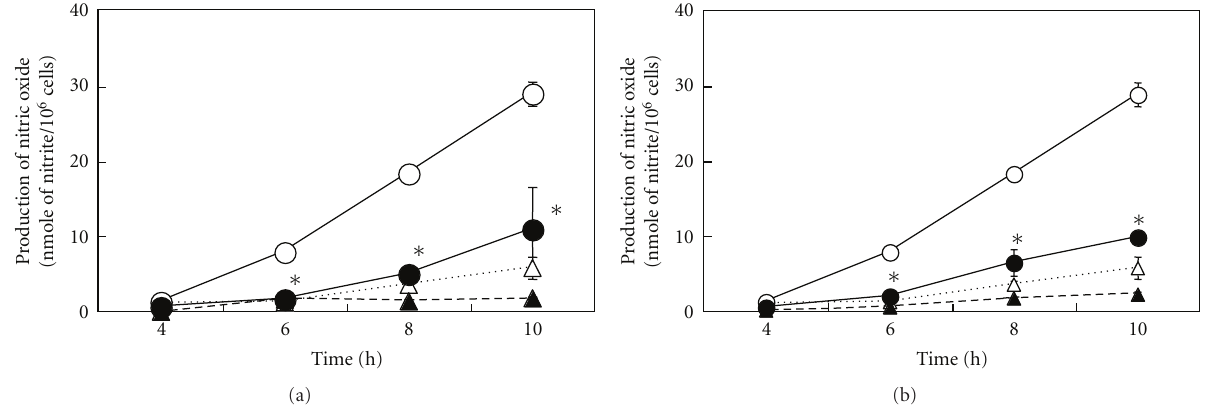
Figure 6: E ff ects of peroxidized EPA/DHA on the time course of NO production. Cells were treated with IL-1 β (1nM) in the presence or absence of peroxidized EPA for 3 days (a) and DHA for 1.5 days (b) (each, 500 μ M) for the indicated times (IL-1 β , open circles; IL-1 β + EPA or DHA, filled circles; EPA or DHA, filled triangles; controls (without IL-1 β and EPA/DHA), open triangles). The levels of nitrite were measured in the culture medium (data are means ± SD for n = 3 dishes/point; ∗ P < . 05 versus IL-1 β